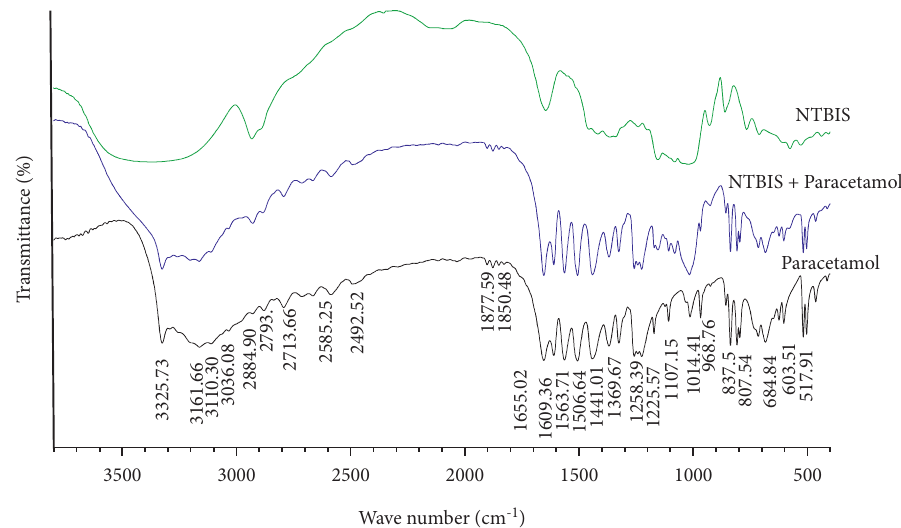
Figure 7: Overlay FTIR spectra of paracetamol, paracetamol mixed with NTBIS (at 1:1 ratio), and NTBIS.